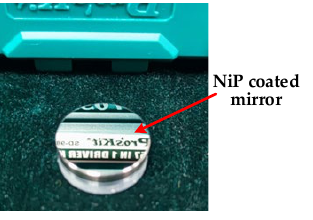
Figure 12. NiP-coated mirror with smoothing